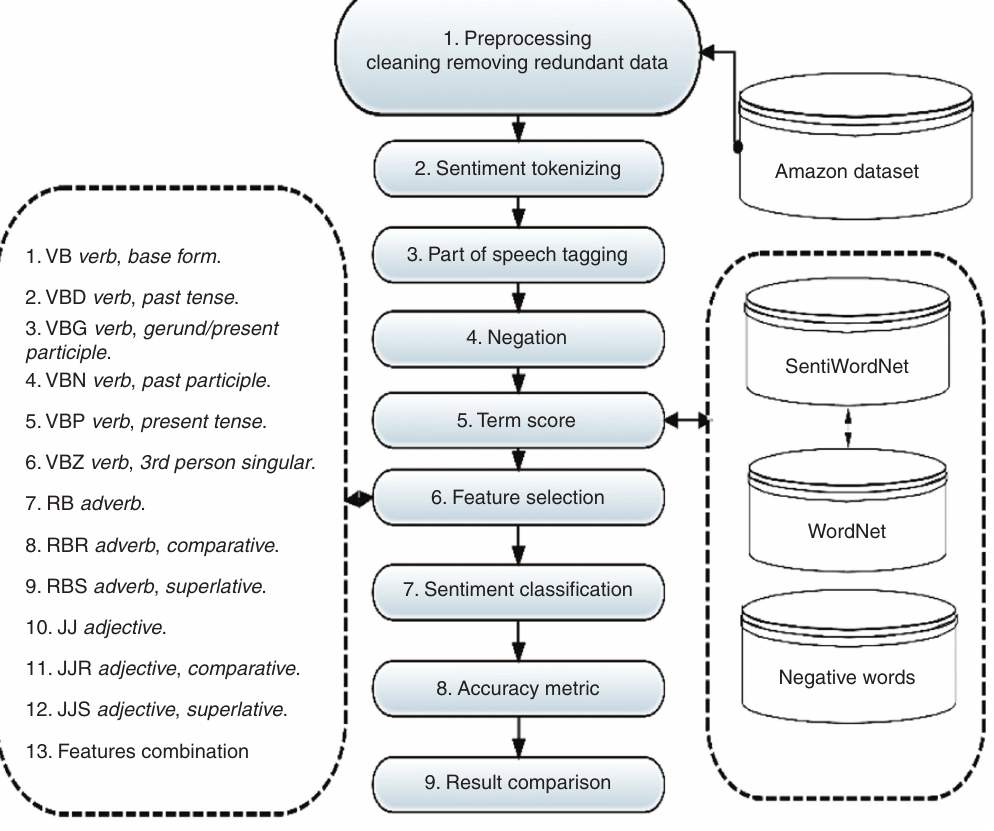
Figure 2: Sentiment Classification